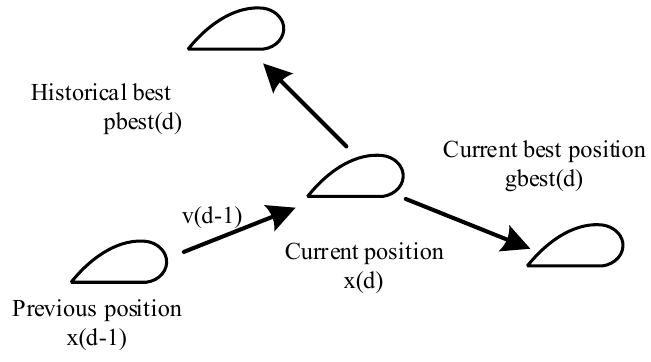
Figure 3. Solution space of particle swarm optimization.